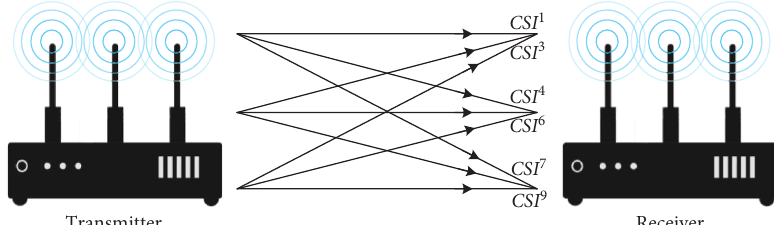
Figure 1: Schematic diagram of MIMO antenna